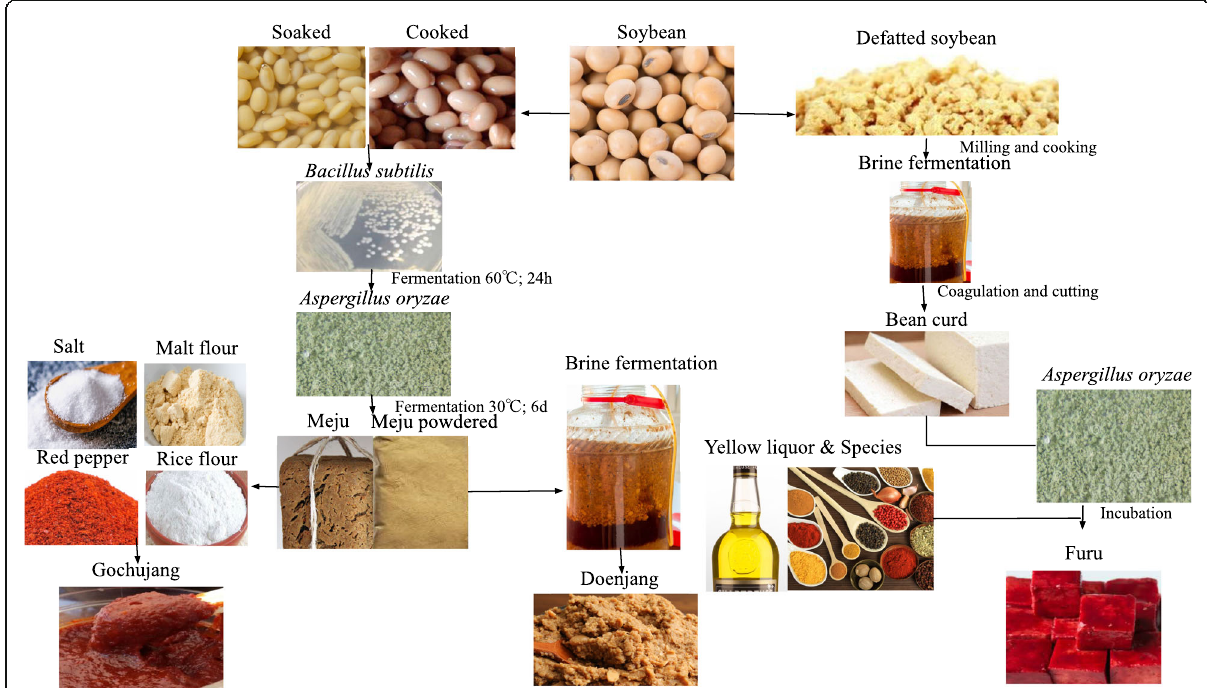
Fig. 2 Fermentation process of cooked and defatted